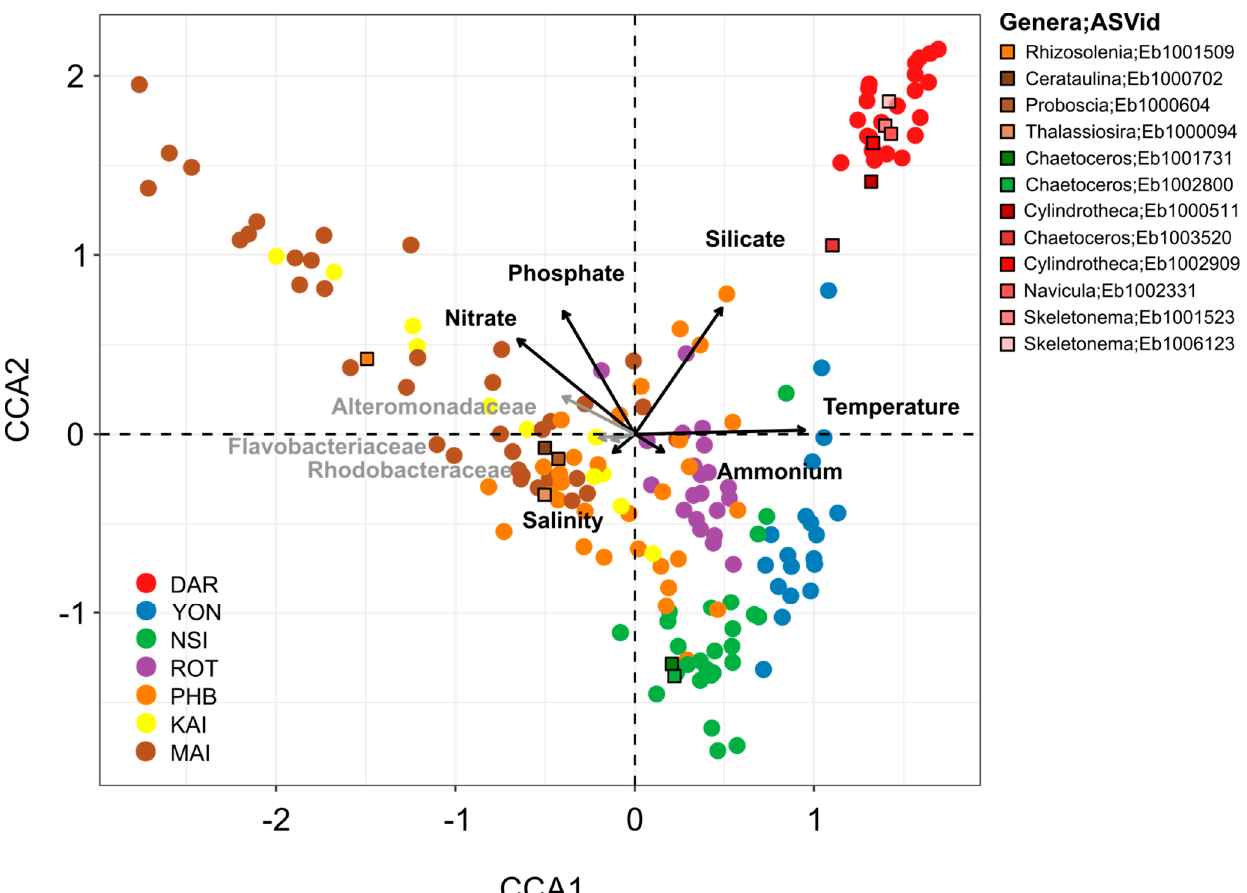
Figure 4. Environmental (nutrient, temperature, and salinity) and Biological (Rhodobacteraceae, Flavobacteriaceae, Alteromonadaceae) Drivers of Diatom Community Composition at Seven Sites around Australia. Diatom community composition over 5 years displayed using Canonical Corre- spondence Analysis (CCA) of rarefied diatom ASVs highlighting the environmental and biological drivers of assemblage composition. Black arrows represent the influence of each environmental var- iable (temperature, salinity, silicate, phosphate, ammonium and nitrate) and grey arrows corre- spond to the influence of three bacteria families most commonly found in association with phyto- plankton (Rhodobacteraceae, Flavobacteriaceae, Alteromonadaceae). Abiotic parameters alone (site, temperature, daylength, silicate, phosphate, nitrate, ammonium, salinity) contributed to ex- plain ~21.2% of the variance observed between diatom community whereas Rhodobacteraceae, Fla- vobacteriaceae and Alteromonadaceae bacteria families contributed to explain ~4.5%. Altogether, biotic and abiotic variables contribute to explain ~25.7% of variance observed between the diatom community. Squares represent diatom ASVs which were among the top 10% most abundant ASVs that were significantly differentially abundant between sites (ANCOM-BC analysis) and were pos- itively correlated with specific bacterial ASVs (network co-occurrence analysis).